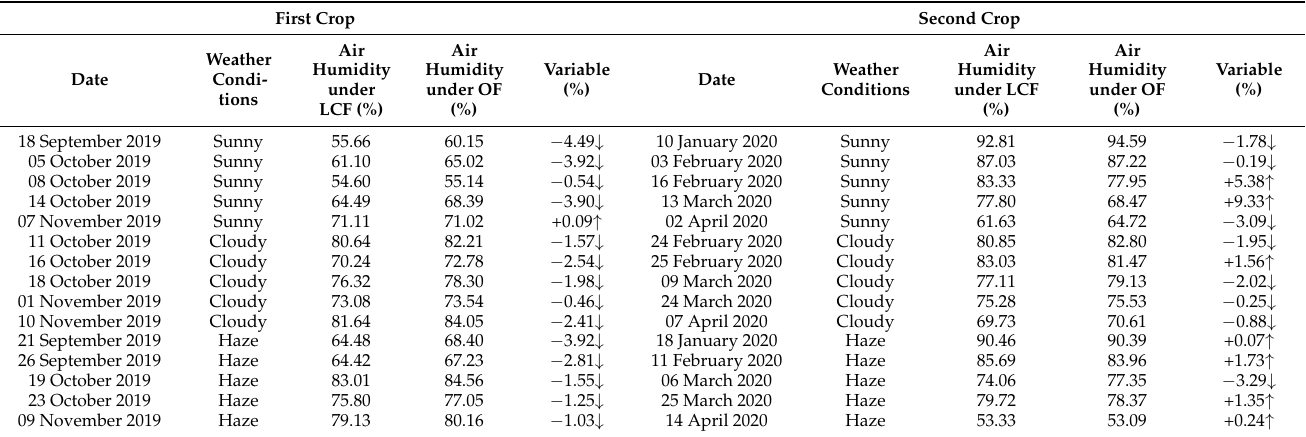
Table 2. Analysis of the effect of different weather on air humidity in light conversion film (LCF) and ordinary film (OF) greenhouses under different